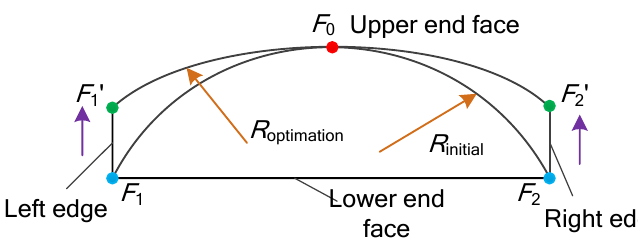
Figure 2. Permanent magnet section.